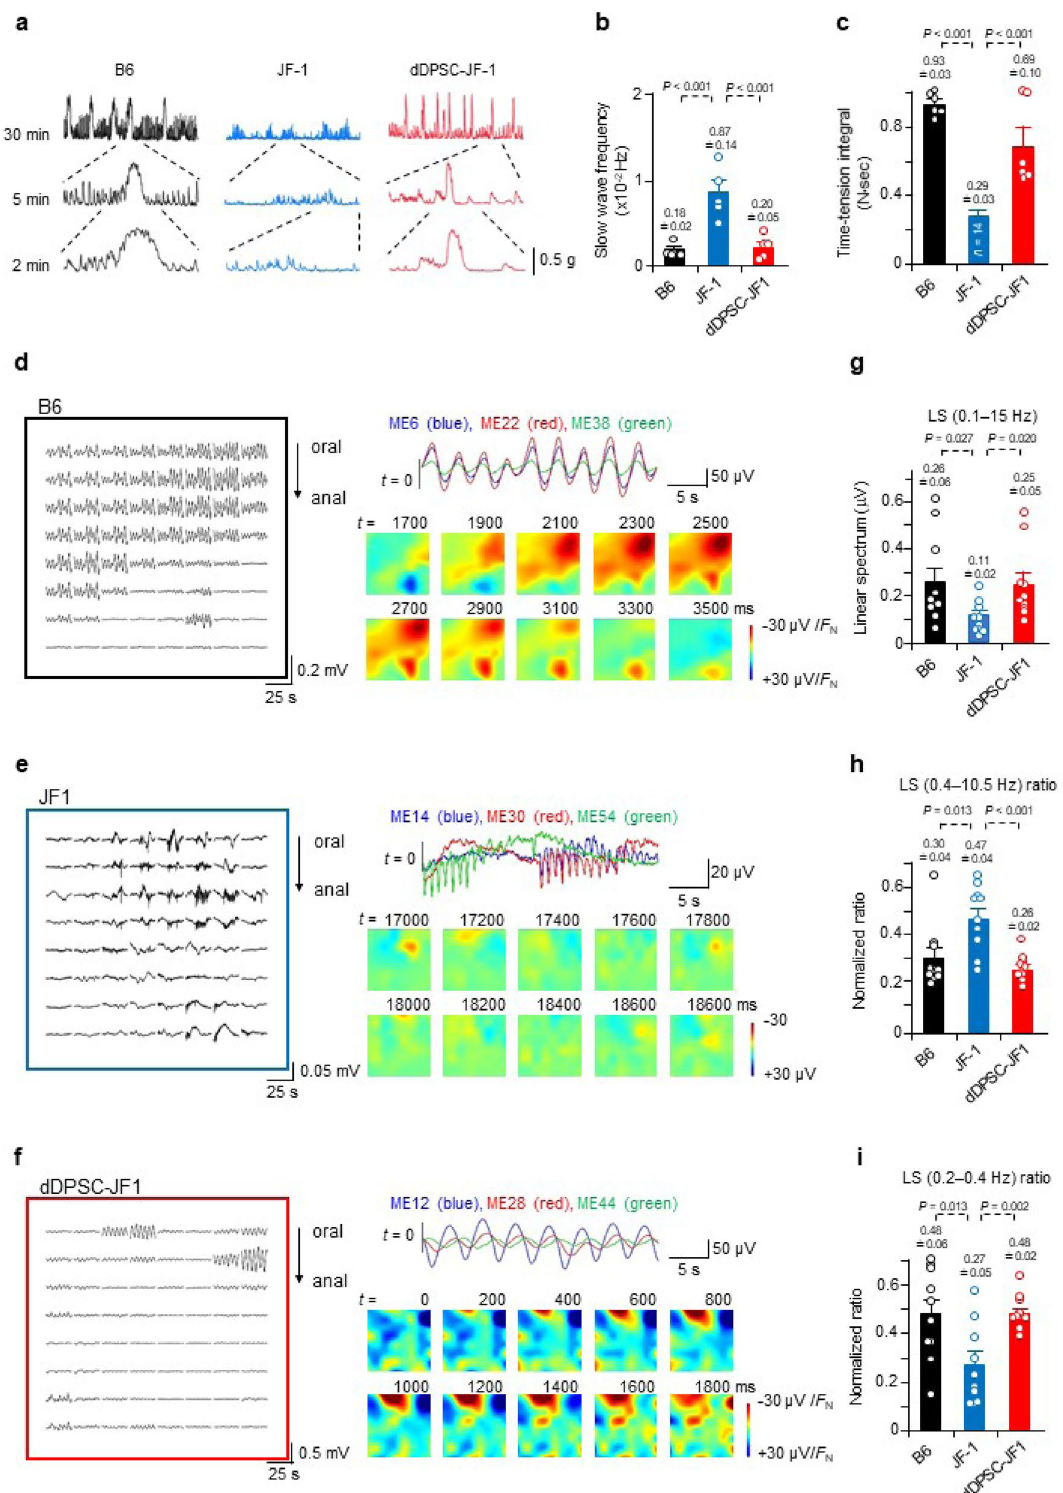
Figure 3. Effects of dDPSCs on colonic function. ( a ) Spontaneous contractions recorded from proximal colon muscle strips. ( b , c ) Slow wave frequency (mean ± SEM, n = 5) and time-tension integral (area under the curve) for the spontaneous contractions (mean ± SEM; B6, n = 6; JF1, n = 14; dDPSC-JF1, n = 7). ( d–f ) Electrical potentials recorded from the proximal colon with an 8 × 8 MEA and the corresponding reconstructed potential maps. ( g–i ) Characteristics of the electrical potentials recorded with the 8 × 8 MEA: potential magnitude, proportion of high-frequency (0.4–10.5 Hz) potentials, and proportion of low-frequency (0.2–0.4 Hz) potentials (mean ± SEM, n = 10). ( a,d–f ) Representative of ≥ 2 independent